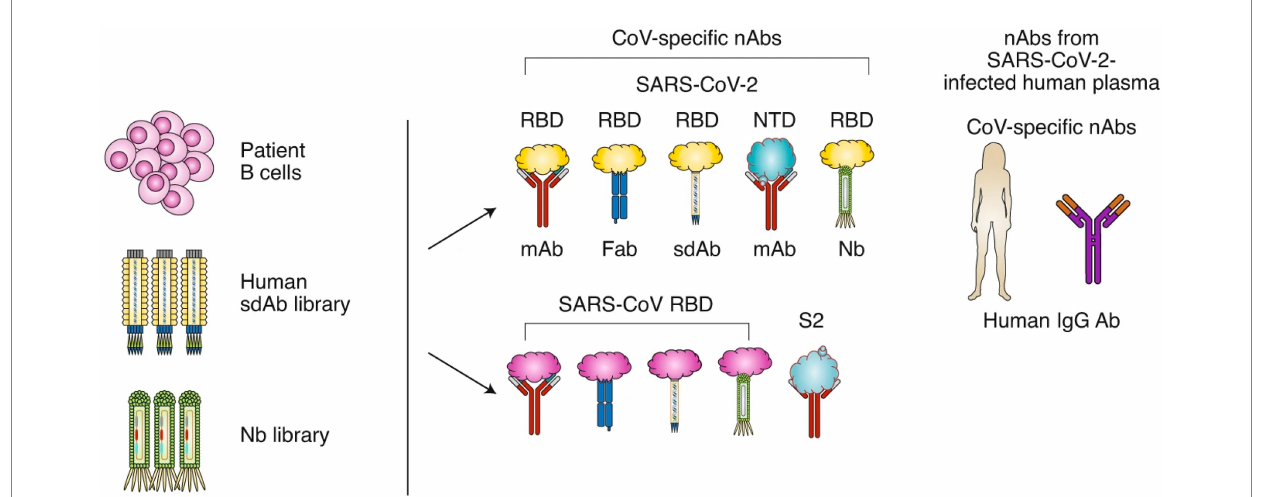
FIGURE 2 The generation type of SARS-CoV2 neutralizing antibodies. SARS-CoV-2 nAbs may be isolated from patients’ B cells, a library of human single-domain antibodies (sdAbs), or a library of nanobodies (Nbs). Different regions of the SARS-CoV-2 S protein are targeted by nAbs, including the RBD and NTD in the S1 subunit. SARS-CoV nAbs with cross-neutralization activity against SARS-CoV-2 may cross-react with the SARS-CoV-2 RBD or S2 subunit. Convalescent plasma from patients infected with SARS-CoV-2 could be used for the treatment of COVID-19. Image and description courtesy of Jiang et al.